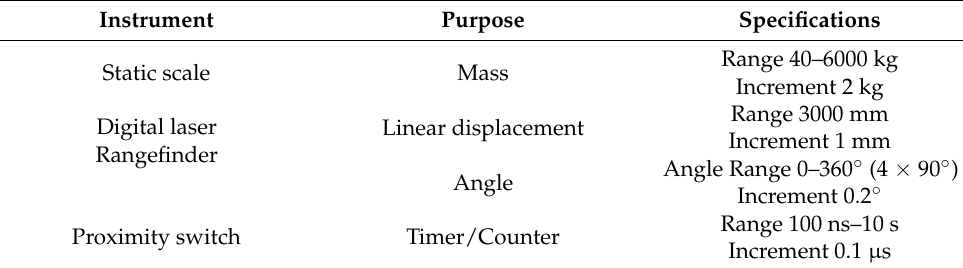
Table 2. Measurement instruments of the tractor preliminary